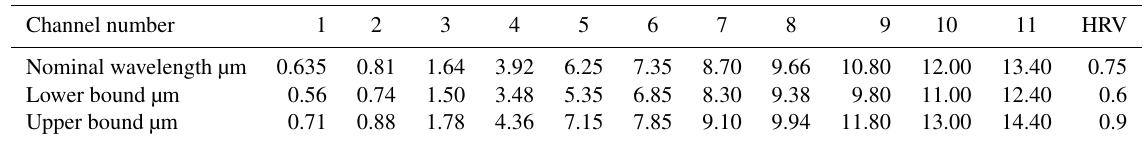
Table 1. Specifications of the SEVIRI channels.